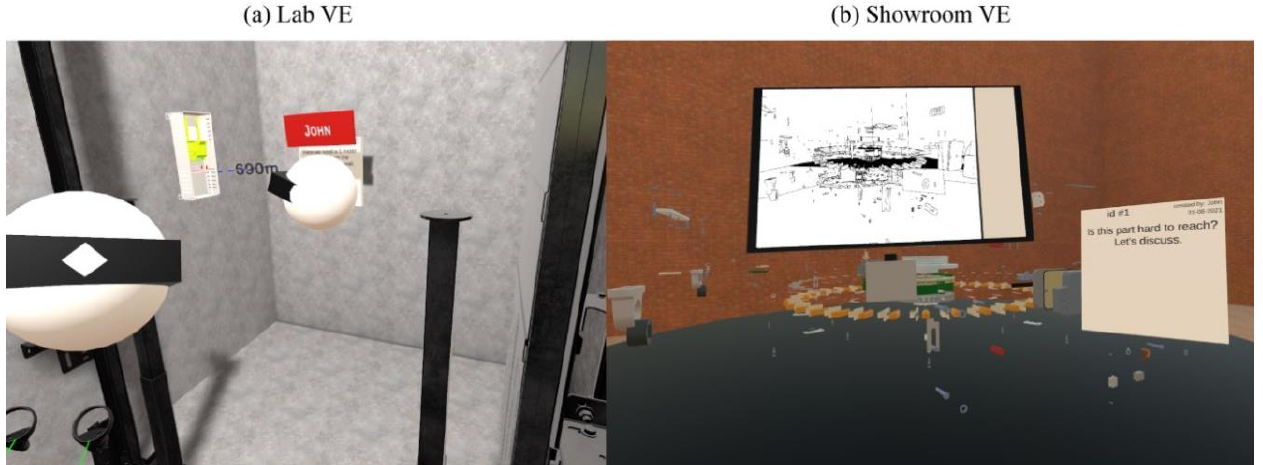
Figure 4. Working virtual environments: ( a ) the Lab VE, which replicates a real elevator shaft and ( b ) the Showroom VE with a disassembled 3D CAD model